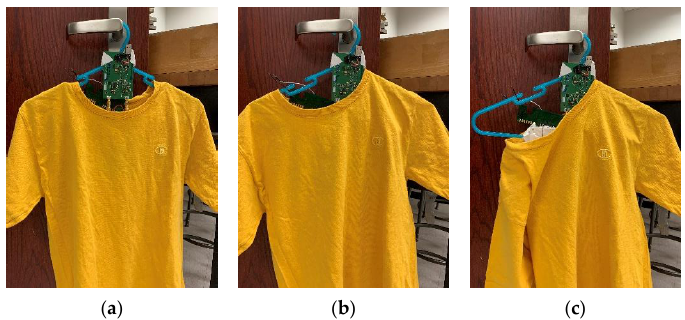
Figure 10. Three measured hanging scenarios: ( a ) neutral position; ( b ) garment slides to one arm; ( c ) garments falls from one arm.